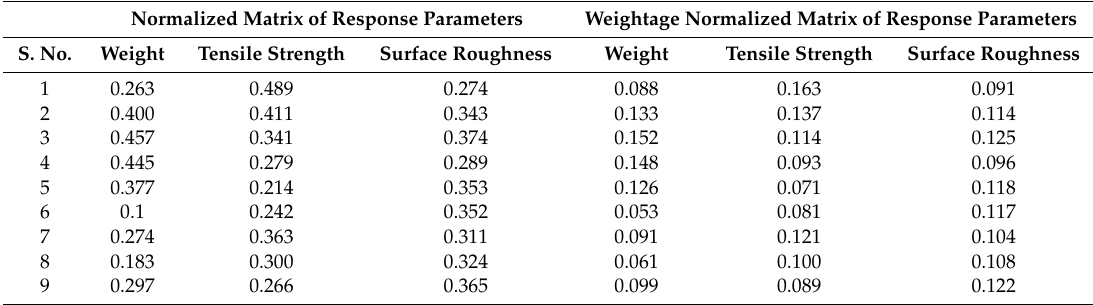
Table 5. Values of normalized and weightage normalized matrix of response parameters. Normalized Matrix of Response Parameters Weightage Normalized Matrix of Response Parameters